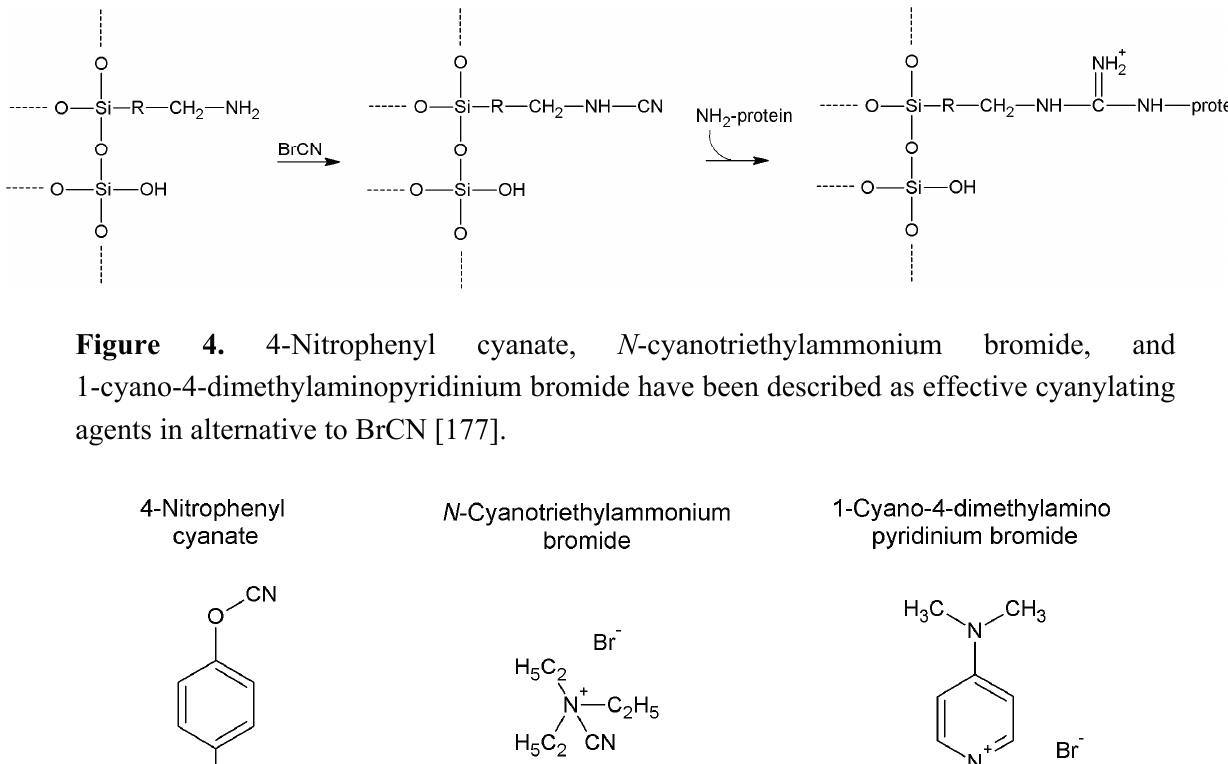
Scheme 5. Reaction pathway for cyanogen bromide activation of amino-functionalized supports.